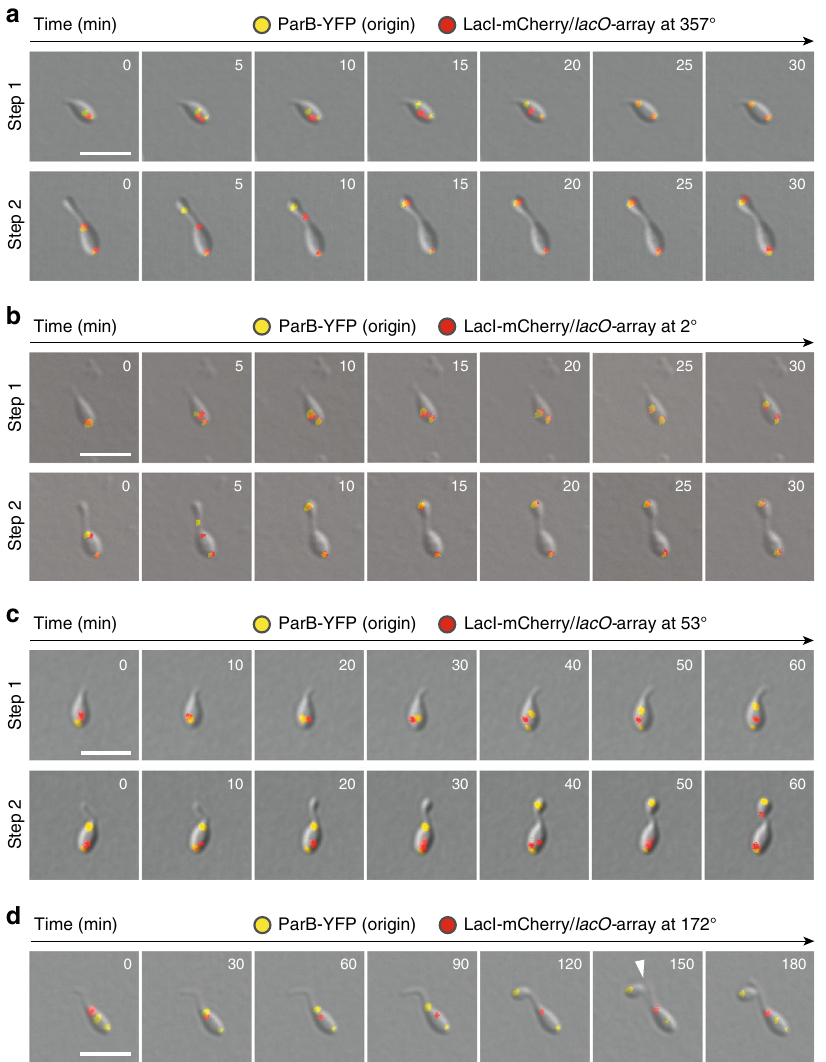
Fig. 8 Dynamics of chromosome segregation. a – d Time-lapse series showing the segregation of a FROS-labeled chromosomal loci positioned at varying distance from the replication origin. Cells of strains a AJ87 ( HNE_3540 ::l acO n parB-yfp P Zn ::P Zn - lacI-mCherry ), b JR50 ( HNE_HNE_0032 ::l acO n parB-yfp P Zn ::P Zn - lacI-mCherry ), c KH24 ( HNE_0552 :: lacO parB-yfp P lacI-mCherry ), and d AJ86 ( HNE_1729 :: lacO parB-yfp P lacI-mCherry ) were induced for 1.5 – 3h n Zn ::P Zn - n Zn ::P Zn - with 0.3mM ZnSO 4 , transferred to an MB-agarose pad, and imaged at regular intervals. Shown are overlays of DIC and fl uorescence images. Bars: 3 µ